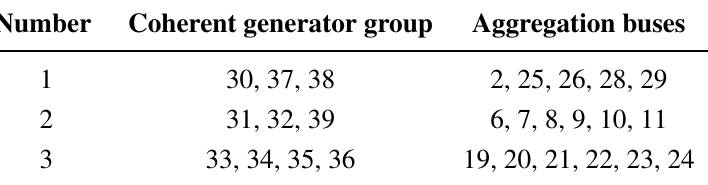
Table 1. Results obtained with the slow coherency grouping algorithm (39-bus).